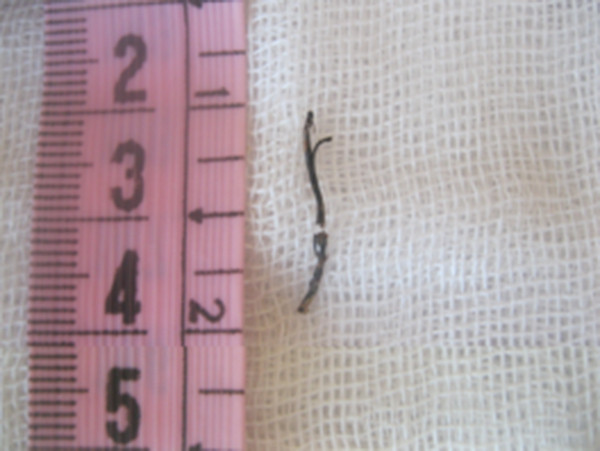
Aspirated thread.